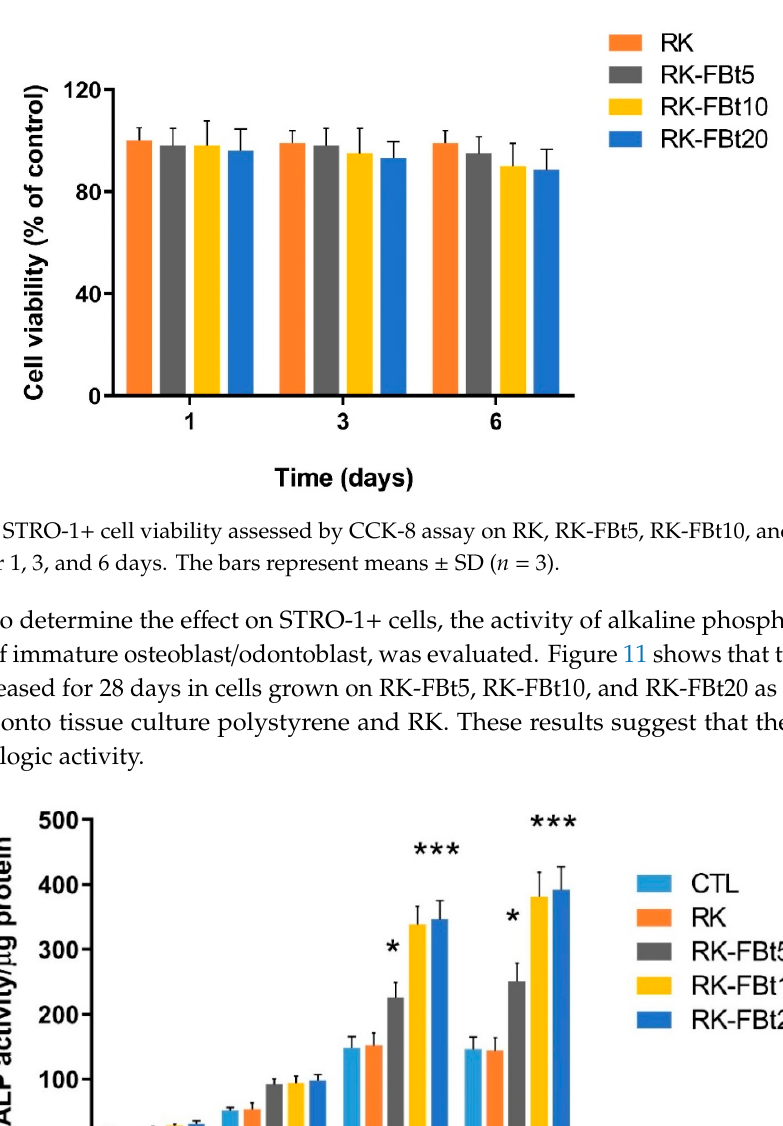
Table 1. Results of inter-group statistical significance of direct contact test (DCT) using Kruskal– Wallis test followed by Dunn’s post hoc analysis. Streptococcus spp.